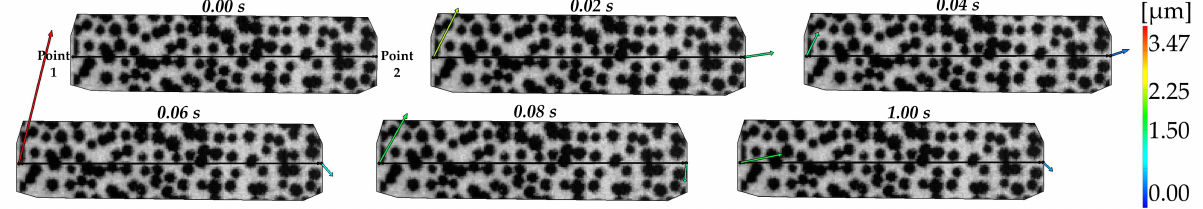
Figure 21. Point vector displacements of static experiment using SP 02 at a frame rate of 50000 f ps